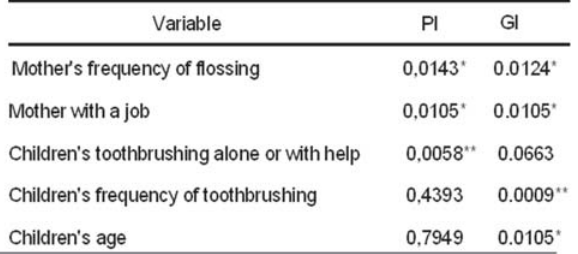
TABLE 5- Covariance analyses for children’s total plaque and gingival indexes